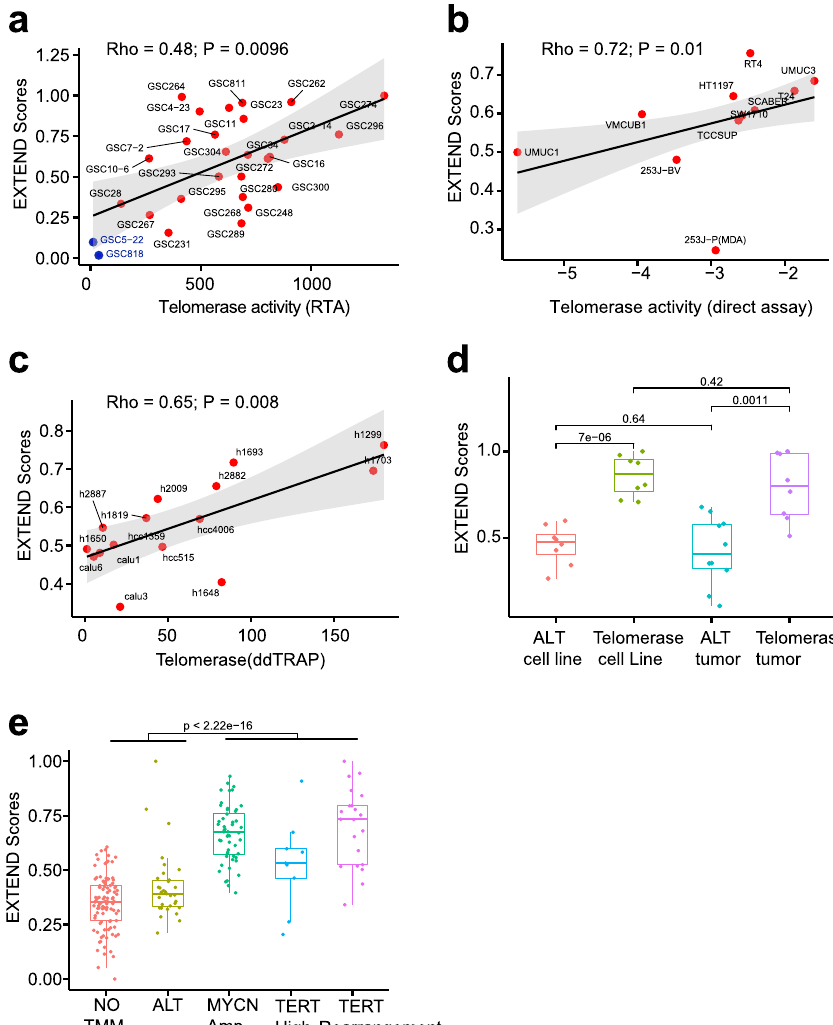
Fig. 1 EXTEND Validation. a Correlation between EXTEND score and TRAP assay readouts in 28 glioma sphere-forming cell lines. Two ALT cell lines are labeled in blue. For ( a – c ), Spearman ’ s correlation was used to calculate P value and Rho, and shade indicates 95% CI of the regression calculated by ggplot2 using default parameters. b Correlation between EXTEND score and direct enzymatic assay results in 11 bladder cancer cell lines. c Correlation between EXTEND score and digital droplet TRAP assay in 15 lung cancer cell lines. d EXTEND scores across ALT and telomerase-positive tumors in liposarcomas ( “ GSE14533 ” ). Both telomerase-positive tumors ( n = 8) and cell lines ( n = 8) show signi fi cantly higher EXTEND scores than ALT samples (cell lines, n = 8 and tumors, n = 10). e EXTEND scores across the fi ve TMM groups of neuroblastoma ( “ GSE120572 ” ). Telomerase-positive groups ( MYCN ampli fi cation ( n = 52), TERT high ( n = 9), and TERT rearrangement ( n = 21)) show signi fi cantly higher scores than ALT ( n = 31) and no TMM ( n = 99) groups. Boxplots, interquartile ranges (25 – 75th percentile); middle bar de fi nes median and the minima and maxima are within 1.5 times the interquartile range of the lower and higher quartile. Statistical differences were assessed using two-sided Student ’ s t test in ( d ) and ( e ). Data used are available in Source